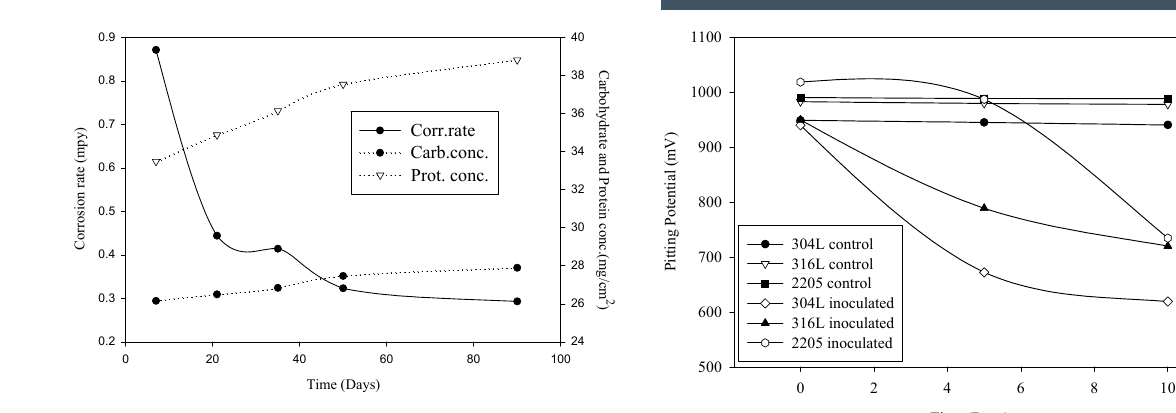
bacteriaTime Fig. 12 Pitting potential of stainless steels in media with/without Figure 12. Pitting potential of stainless steels in media with/without bacteria.